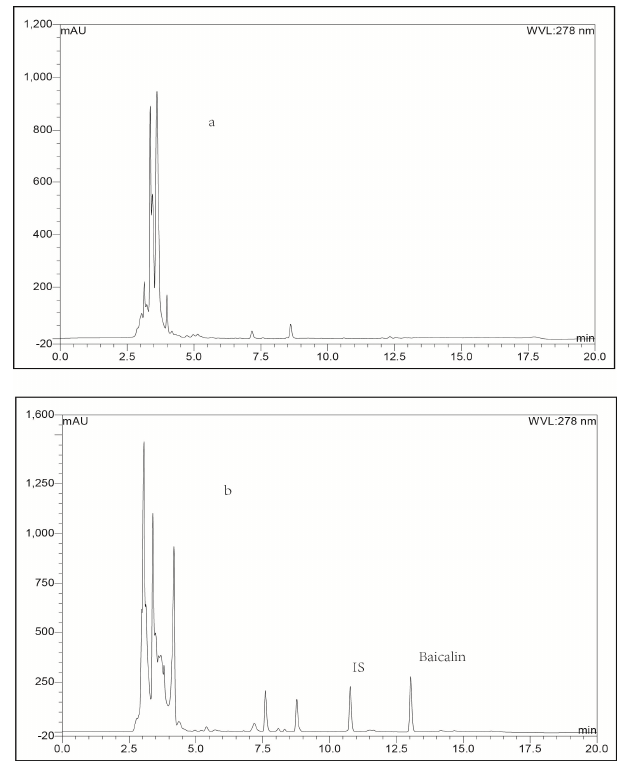
Figure 5. Representative LC-UV chromatograms obtained for blank liver tissue ( a ) and liver bio-sample collected from a rabbit at 0.25 h after intravenous administration of baicalin-loaded liposomes at a dose of 10 mg/kg + IS ( b ).